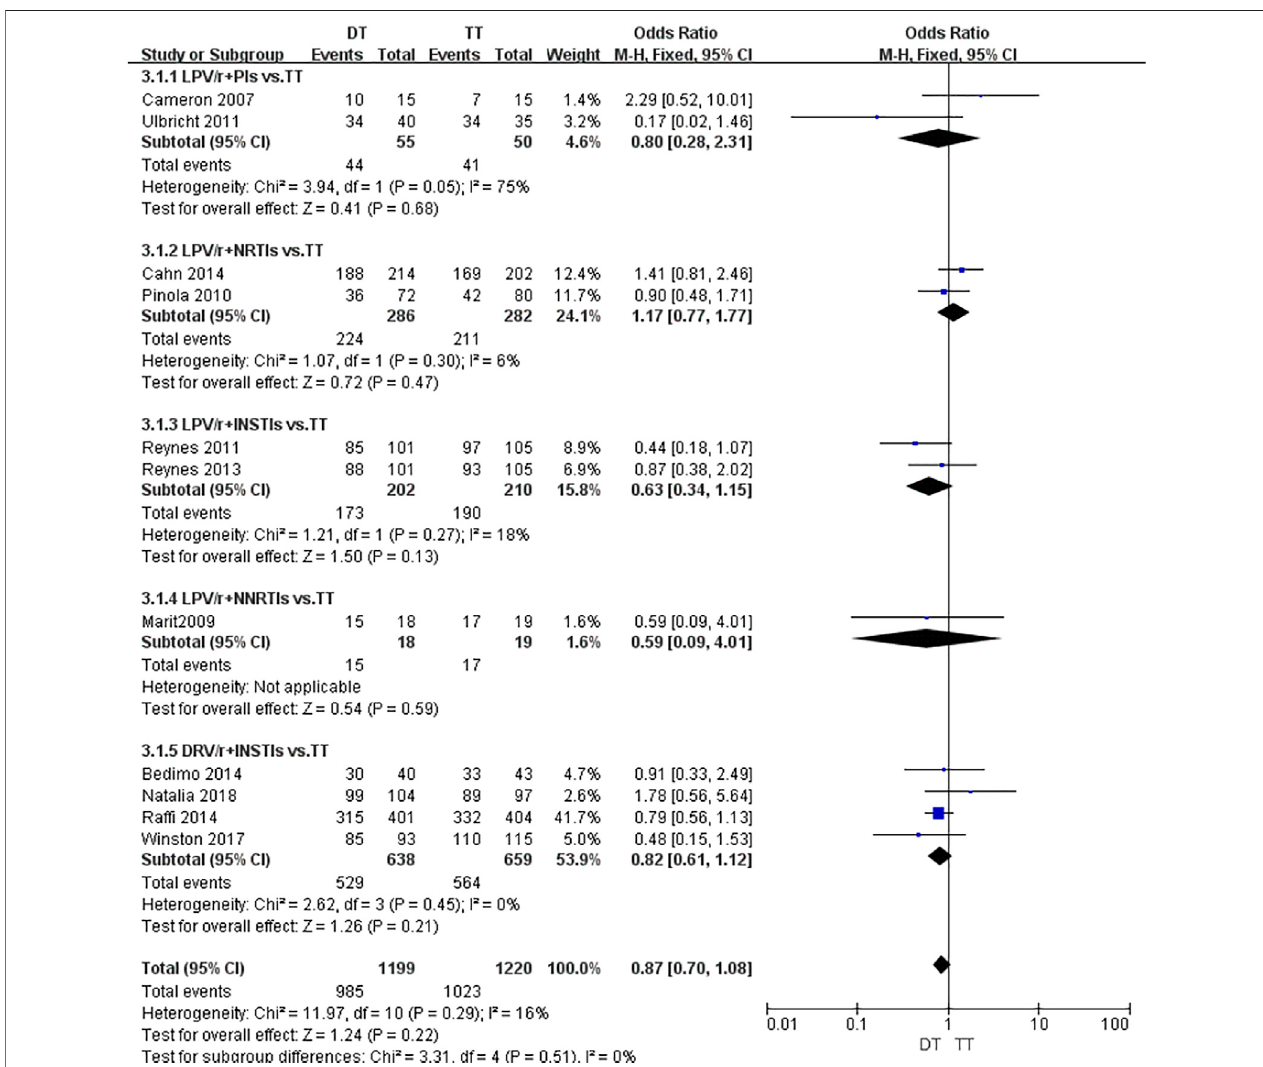
FIGURE 4 | Node-splitting of network meta-analysis based on viral suppression.